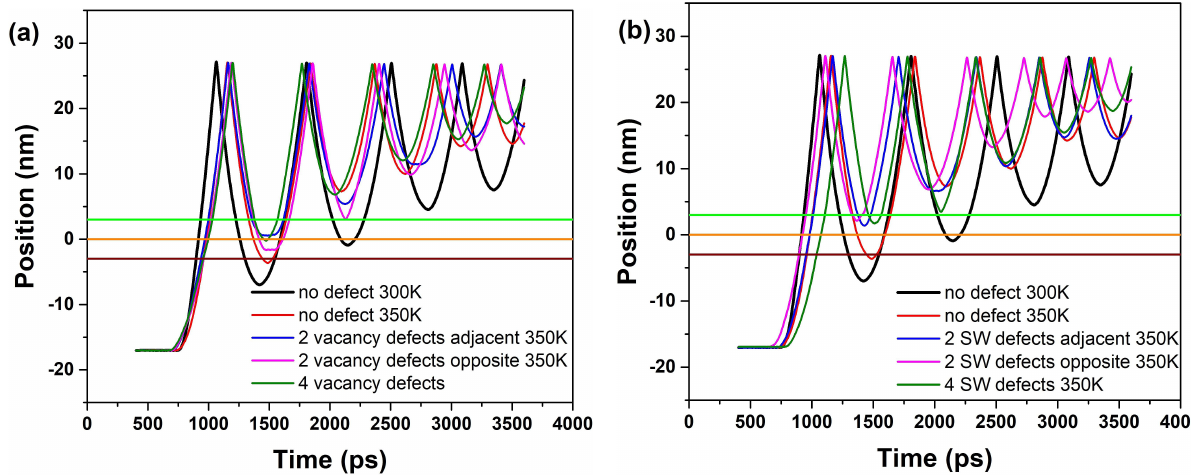
Figure 12: Variation of the movement behaviors with time for the system in 350K and 300K: (a) The system containing no defect, 2 vacancy defects adjacent, 2 vacancy defects opposite, 4 SW defects in the inner nanotube, (b) The system containing no defect, 2 SW defects adjacent, 2 SW defects opposite, 4 SW defects in the inner